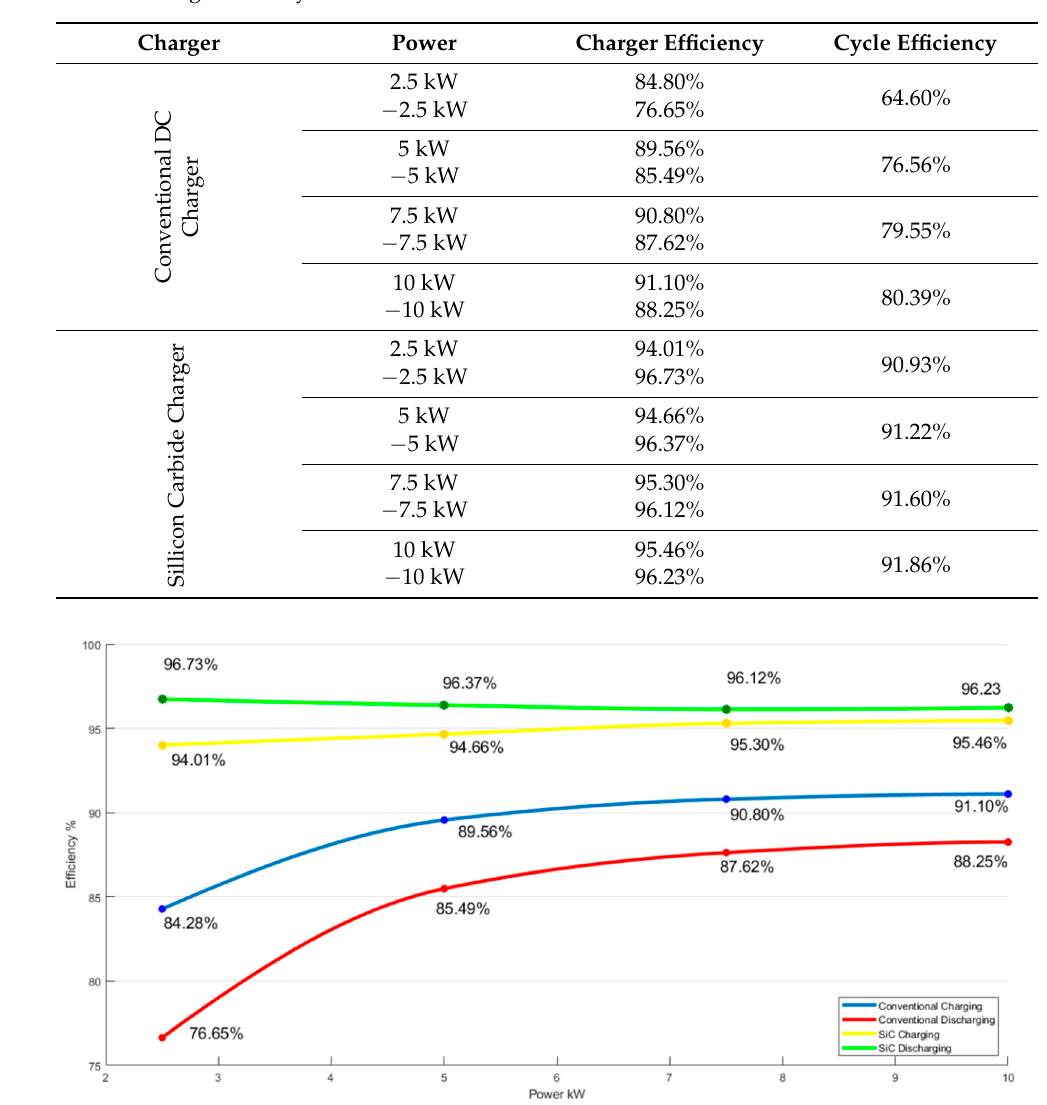
Figure 7. Current harmonics with a conventional charger. 3.4. Economic Assessment Using the aforementioned results, an economic assessment was carried out, consid- ering several different scenarios for the DEEC building. Net load diagrams for a weekday and a weekend day are presented in Figure 8a,b. In these load diagrams, the impact of PV